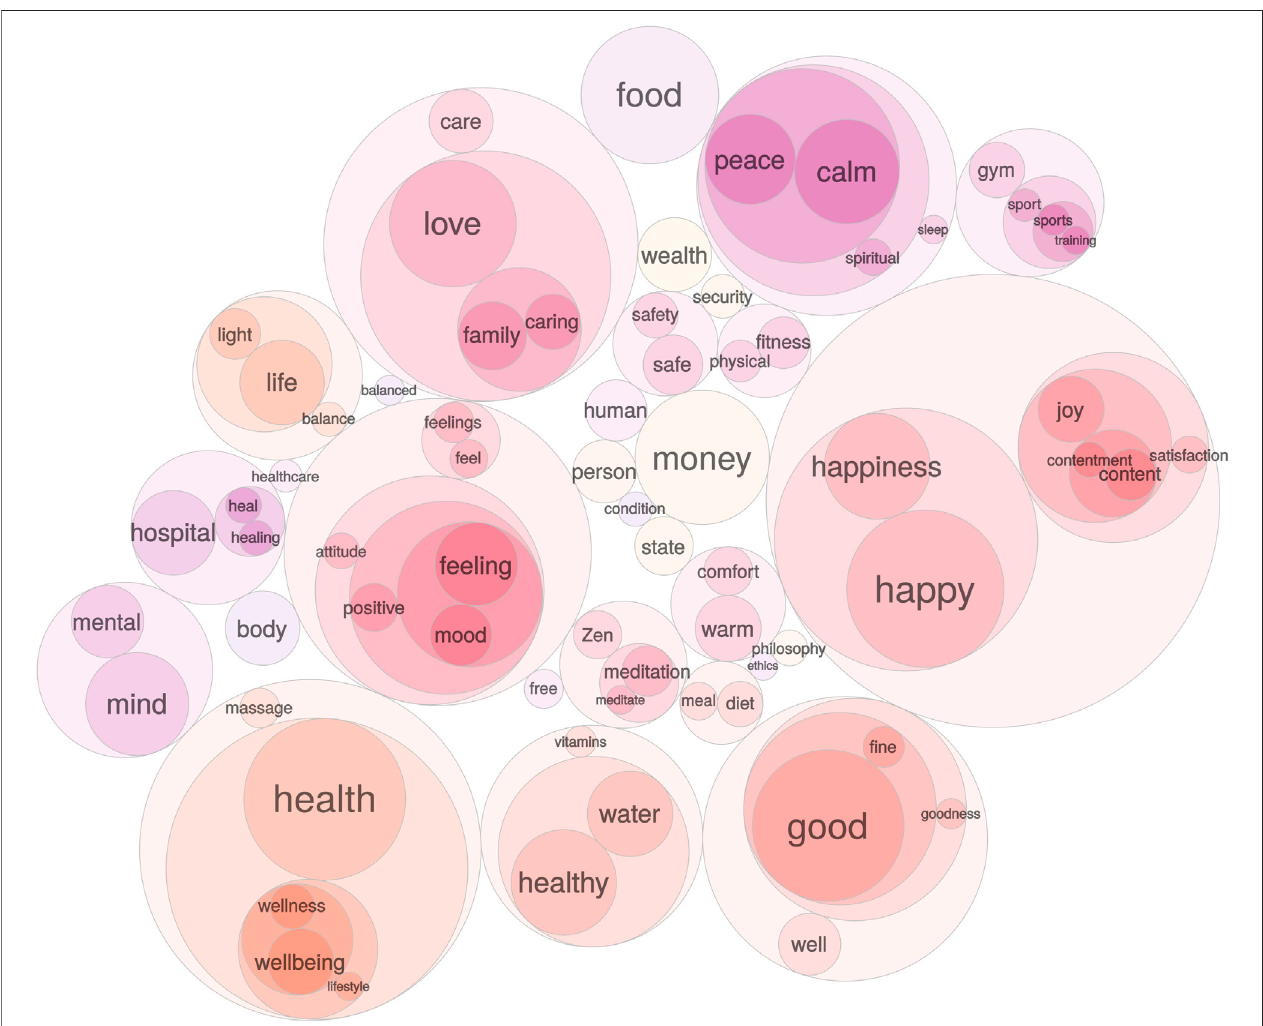
FIGURE1 | Word association egograph for “ well-being ” . Colors indicate distinctclustersof meaning extracted using walktrap clustering. Clustersize indicates the prevalence of association responses measured as response in-strength (i.e., the sum of weighted incoming edges).